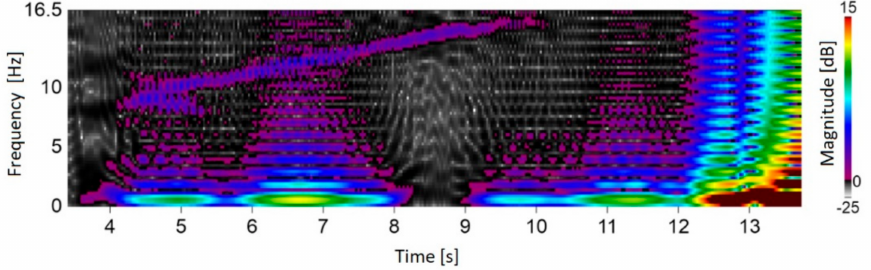
Figure 8. The result of STFT application for ECT data. Material concentration changes in silo cross-section during discharging process (own